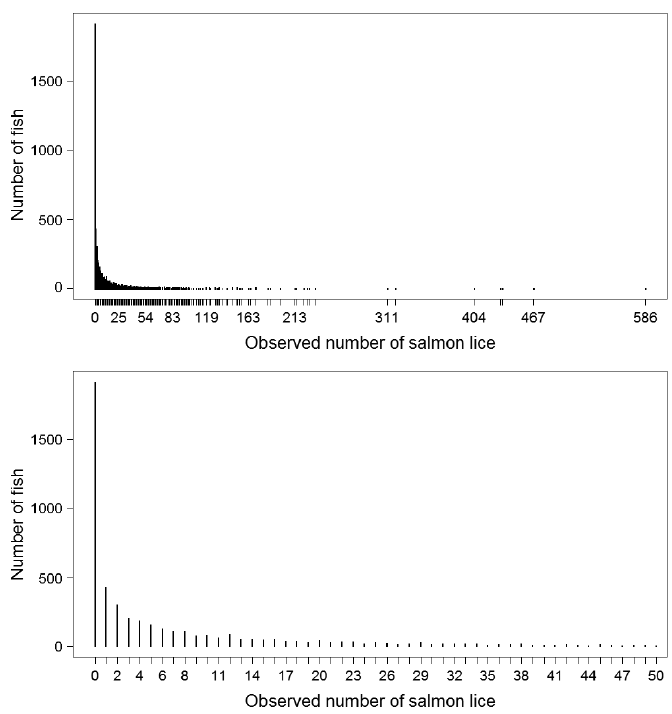
Fig. 2. Frequencies of total number of salmon lice Lepeoph- theirus salmonis counted on wild sea trout Salmo trutta . The lower panel shows the same data as presented in the upper panel, but includes only lice counts of ≤